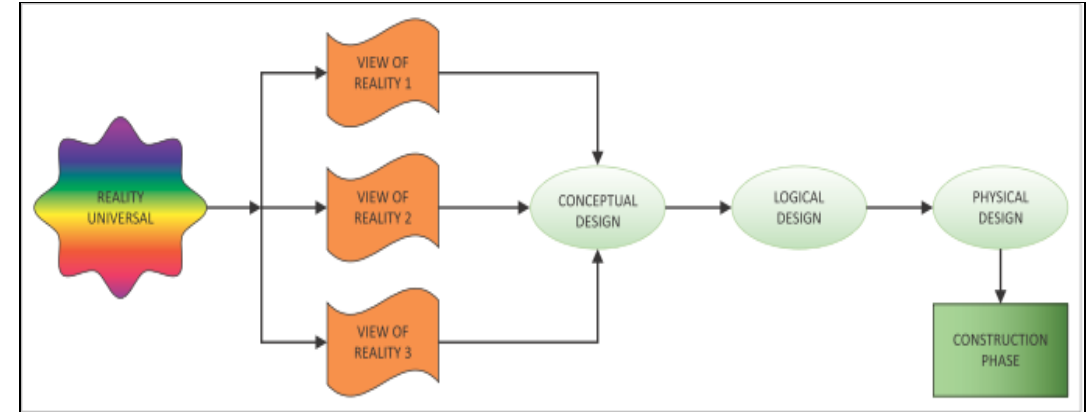
Figure 5 Database Design and Construction (Kufoniyi,